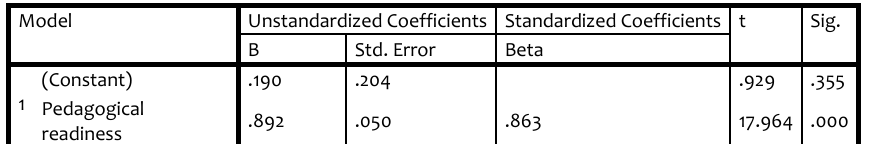
Table 7: Coefficients for Pedagogical Readiness